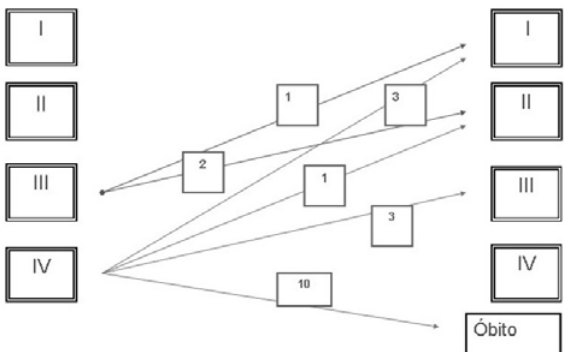
Fig. 3 - Distribuição da classe funcional, aos 48 meses de